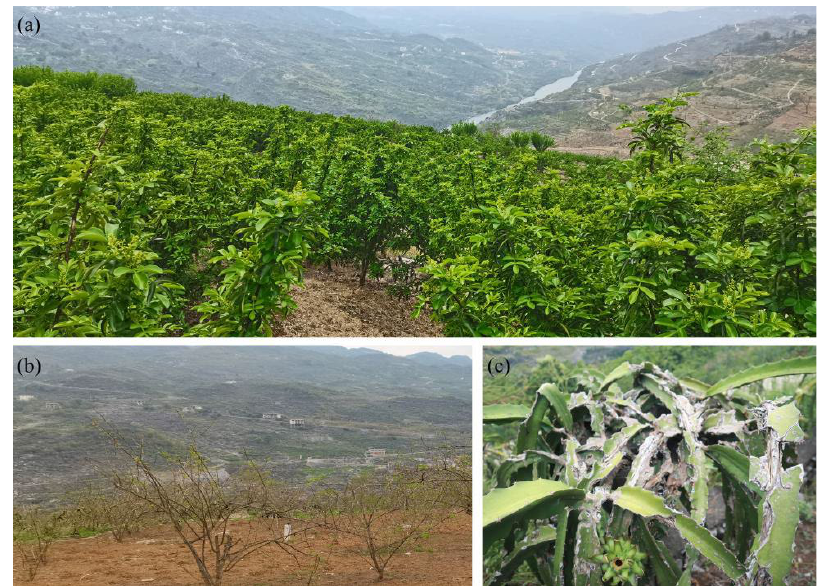
Figure 8. Agroforestry under sudden events: ( a ) Normal growth of prickly pepper; ( b ) prickly pepper under extreme weather; ( c ) dragon fruit with severe pests and diseases.